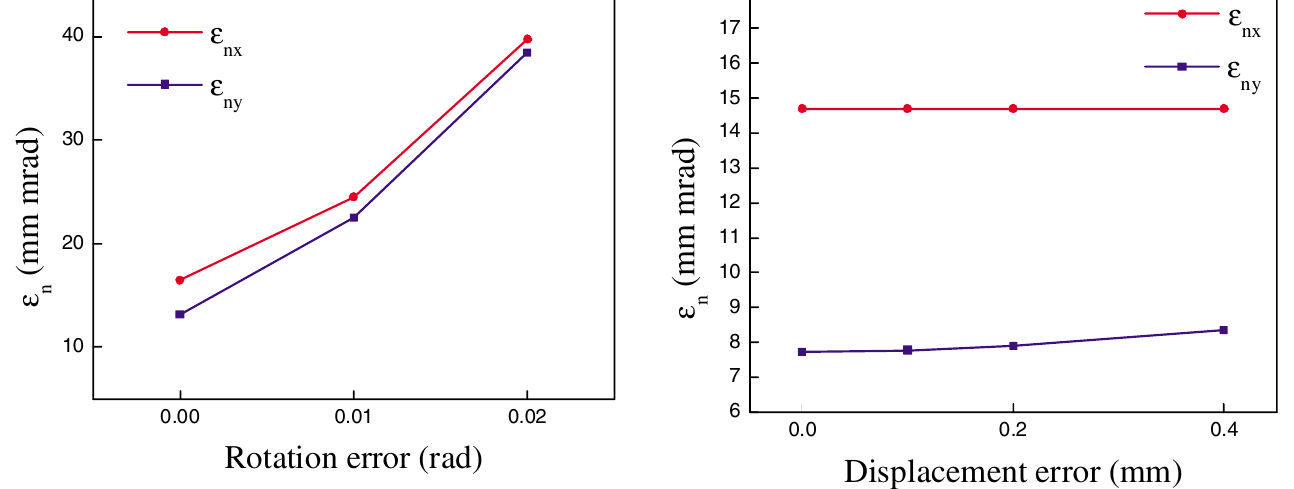
FIG. 10. (Color) Effect of magnet-center errors on emittance.